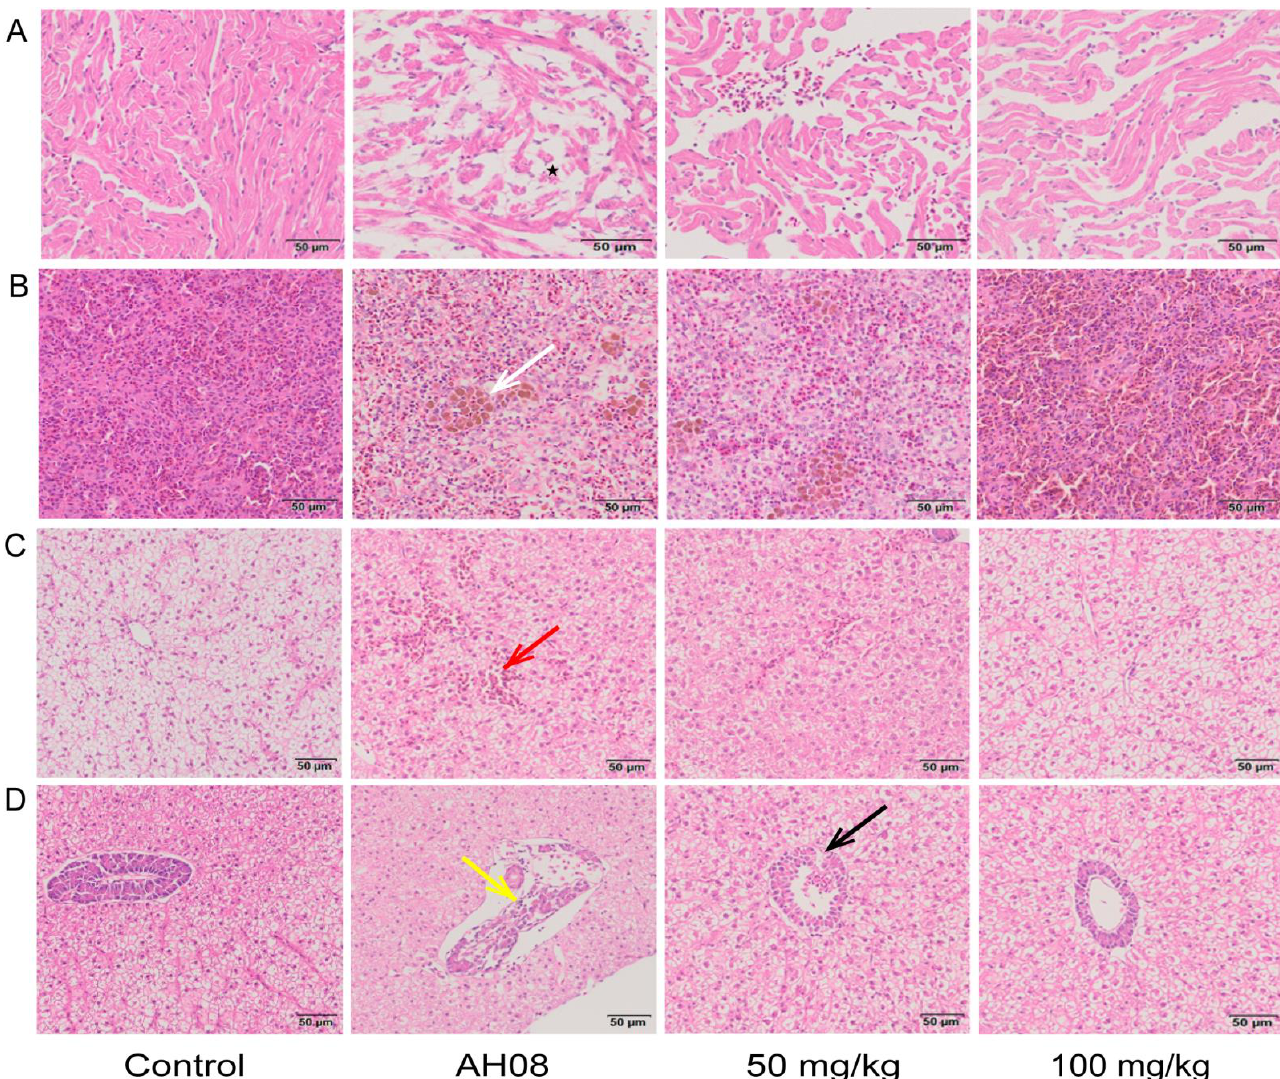
Figure 6. Histopathological analysis for selected tissues from various groups. Umbelliferone alleviated A. hydrophila -induced heart ( A ), spleen ( B ), and hepatopancreas ( C , D ) injury in grass carps. The sections were stained with H&E. Cardiomyocytes were dispersed (black star), deposited hemosiderin granules in the spleen (white arrows), apparent congestion of hepatic sinusoids (red arrow), cytoplasmic pyknosis (yellow arrow), and mild pericardial edema (black arrow).